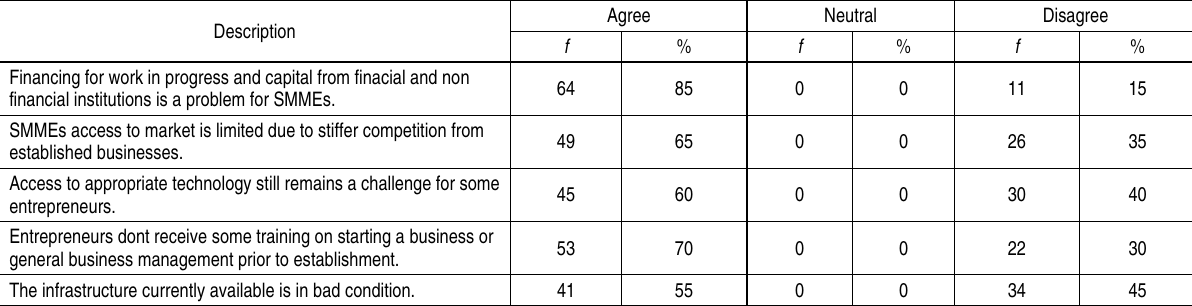
Table 3. Barriers affecting development of SMMEs